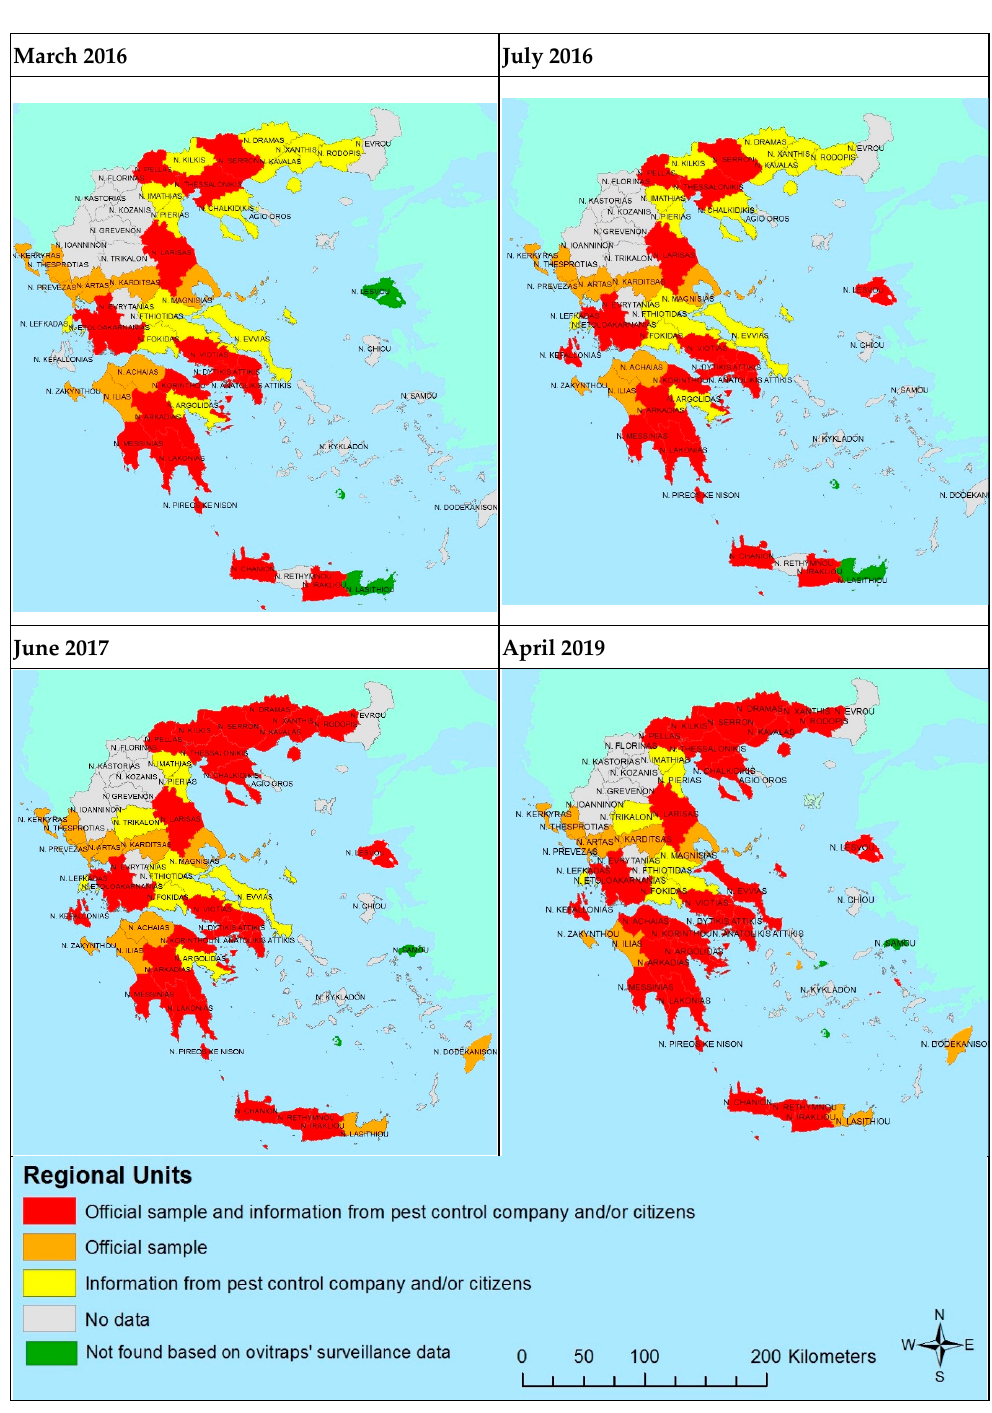
Figure 8. Distribution of Aedes albopictus in Greece